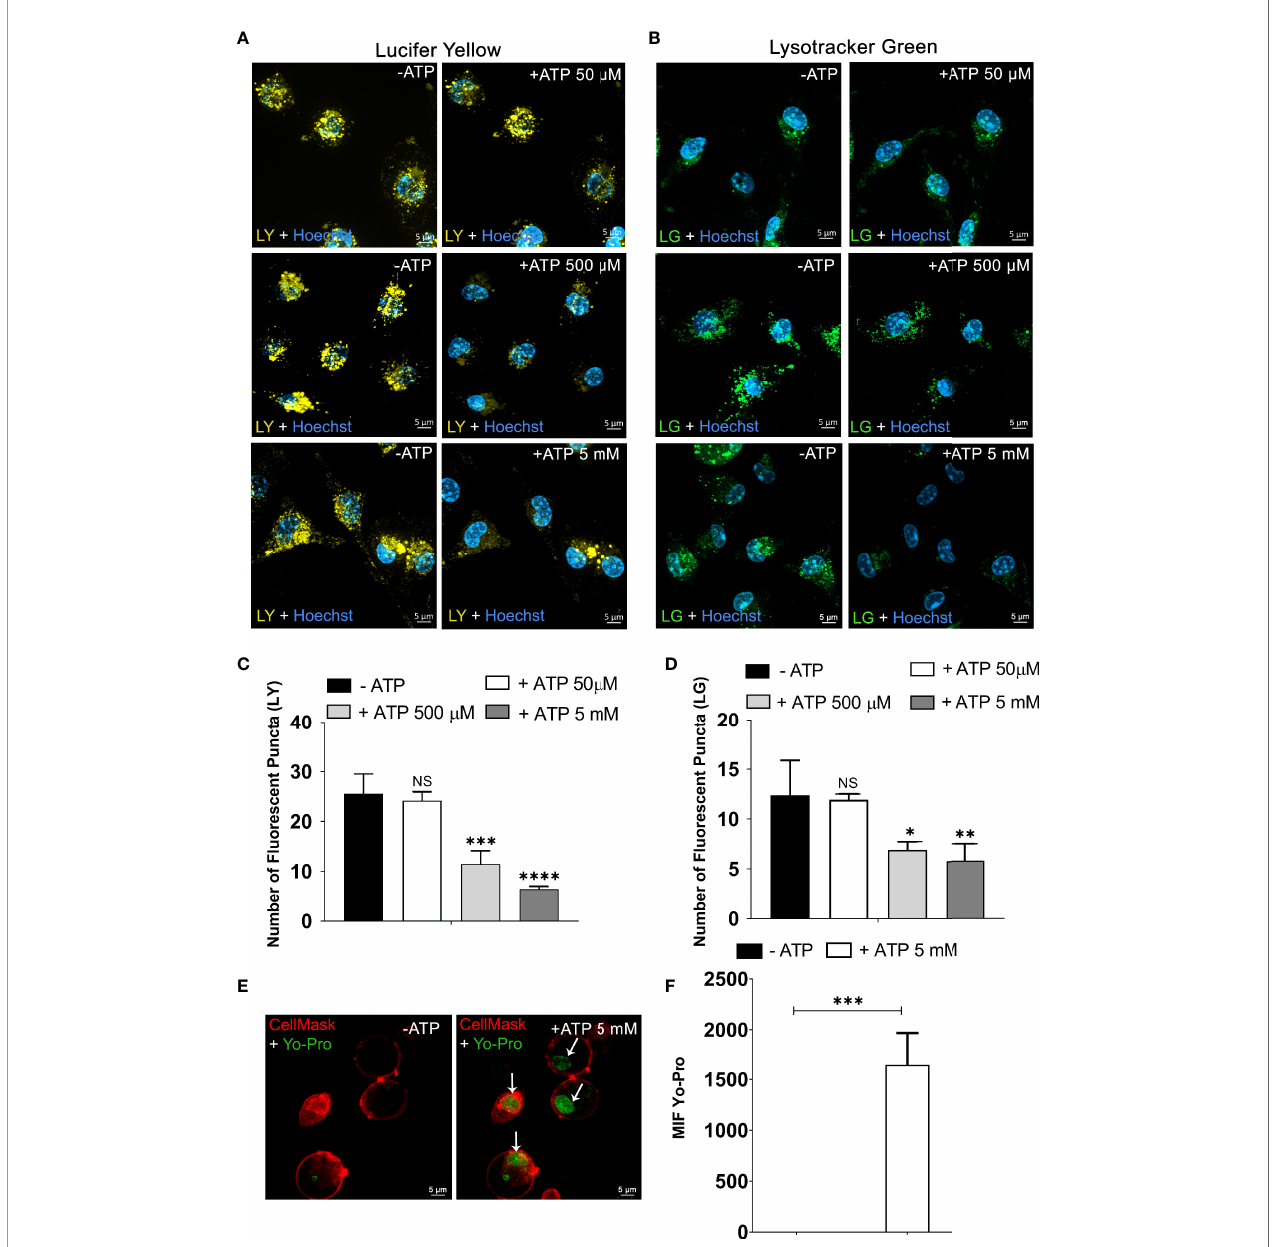
FIGURE 1 | Extracellular ATP Triggers the Rupture of Endosomes/Endolysosomes and Lysosomes. Representative confocal microscope images of peritoneal macrophages from C57Bl/6 WT labeled with (A) 1 mM of Lucifer Yellow (LY) and (B) 50 nM of Lysotracker Green (LG) for 45 min and then treated or not with ATP (50 µM, 500 µM, or 5 mM) at 37°C for 10 min. (C) The number of fl uorescent puncta per cell stained with Lucifer Yellow and (D) the number of fl uorescent puncta per cell marked with Lysotracker Green counted before and after ATP treatment. (E) Representative images of peritoneal macrophages labeled with DNA stain YO- PRO ® -1 for 45 min at 37°C. (F) MFI of nuclei stained with YO-PRO ® -1 from image E was quanti fi ed using Zen Lite Blue software with the background subtracted. Cells were visualized using confocal microscopy before and after stimulation with 5 mM ATP at 37°C for 10 min and nuclei stained with Hoechst. Scale bar, 5 µM; original magni fi cation 100x. Data are expressed as mean ± SEM of three independent experiments performed in triplicate. (C, D) One-way analysis of variance to compare the number of fl uorescent puncta after treatment with ATP vs. the number without treatment. (F) T-test analysis to compare the condition of 10 min after treatment with ATP vs. without treatment with ATP. *P < 0.05, **P < 0.01, ***P < 0.001, and ****P < 0.0001. NS, not signi fi